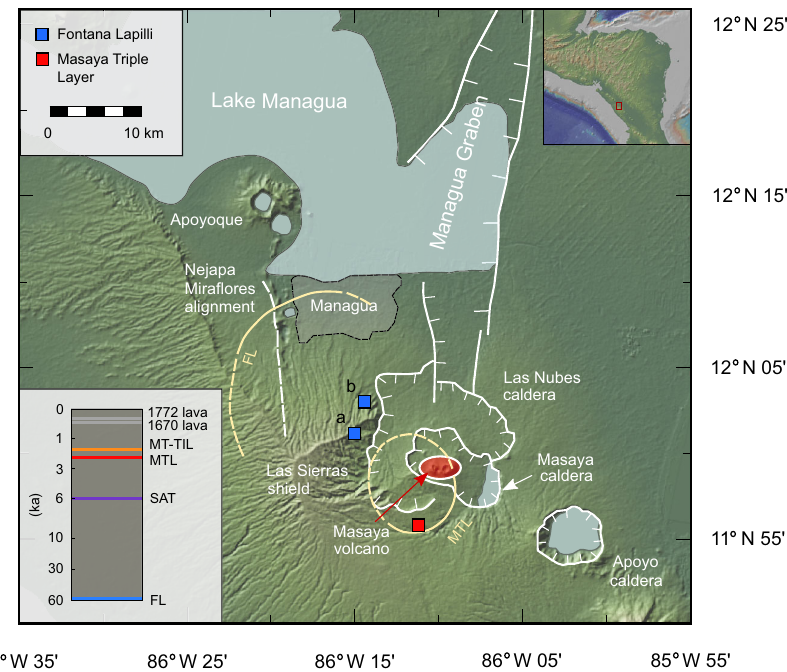
Fig. 1 Map showing the location of Masaya caldera and proximal volcanic and tectonic features. The current active centre of Masaya volcano is highlighted in red. Sampling locations for the FL and MTL eruptions are indicated by blue and red squares respectively. The inset map shows the location of the study area. The stratigraphic column shows the Plinian eruptions of Las Sierras-Masaya volcanic system and the 1670 and 1772 eruptions which produced lava fl ows 22 . The 50 cm isopach for the Fontana Lapilli eruption 2 and the 40 cm isopach for the MTL eruption (subunit II of Pérez et al. 3 ) are highlighted in yellow. Structural features in the Masaya area 18 are highlighted in white. The maps were made using GeoMapApp 85 (http://www.